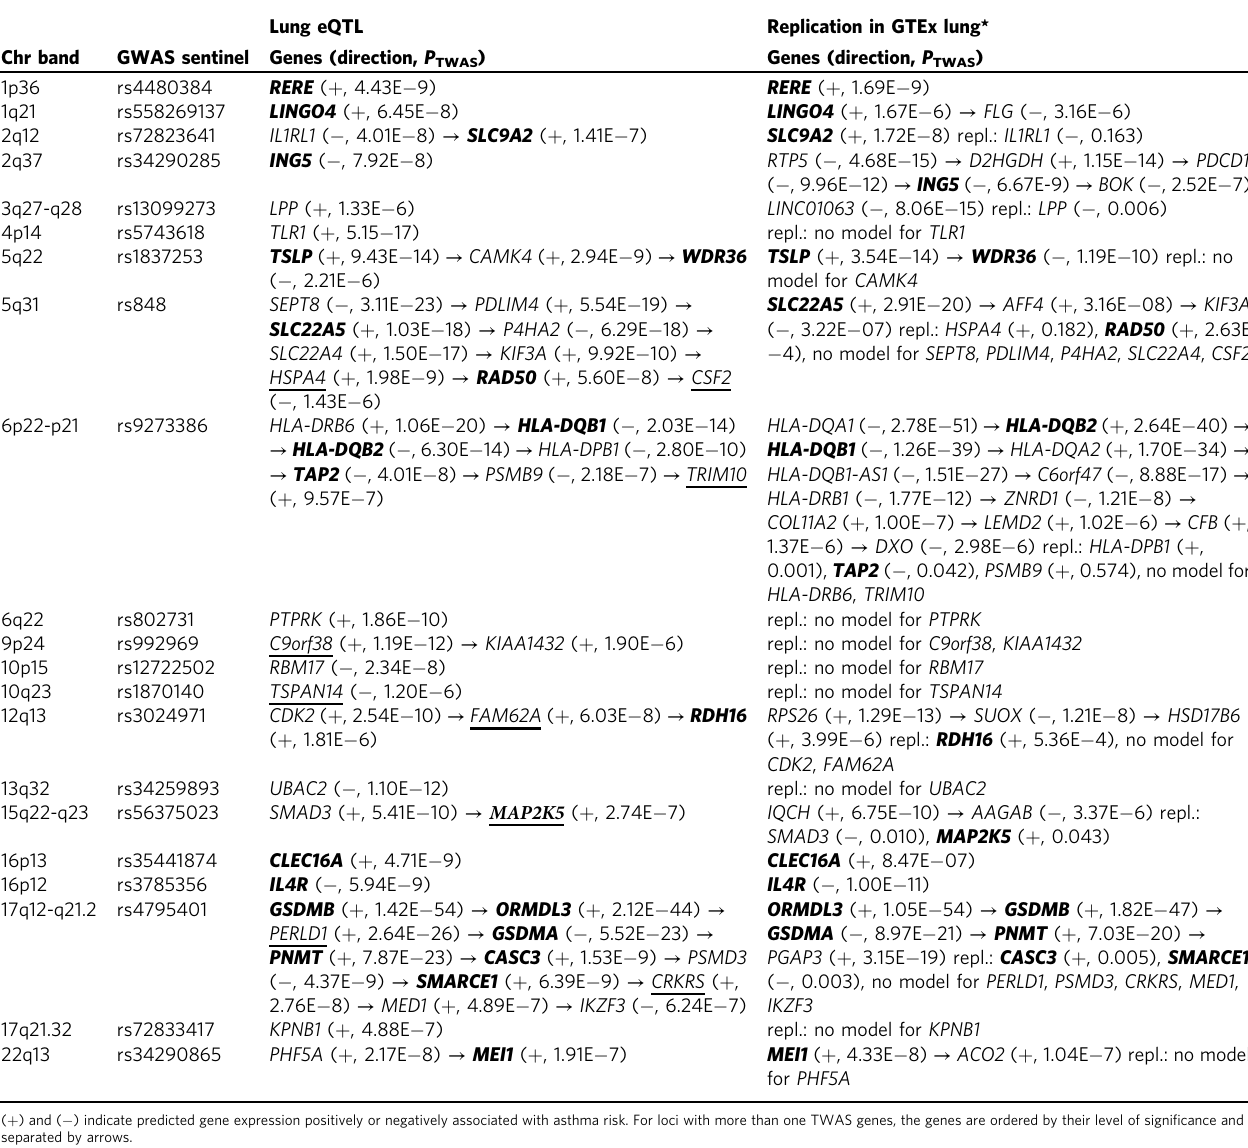
Table 3 Lung TWAS genes identi fi ed in asthma-associated loci. Lung eQTL Replication in GTEx lung* Chr band GWAS sentinel Genes (direction, P TWAS ) Genes (direction, P TWAS )